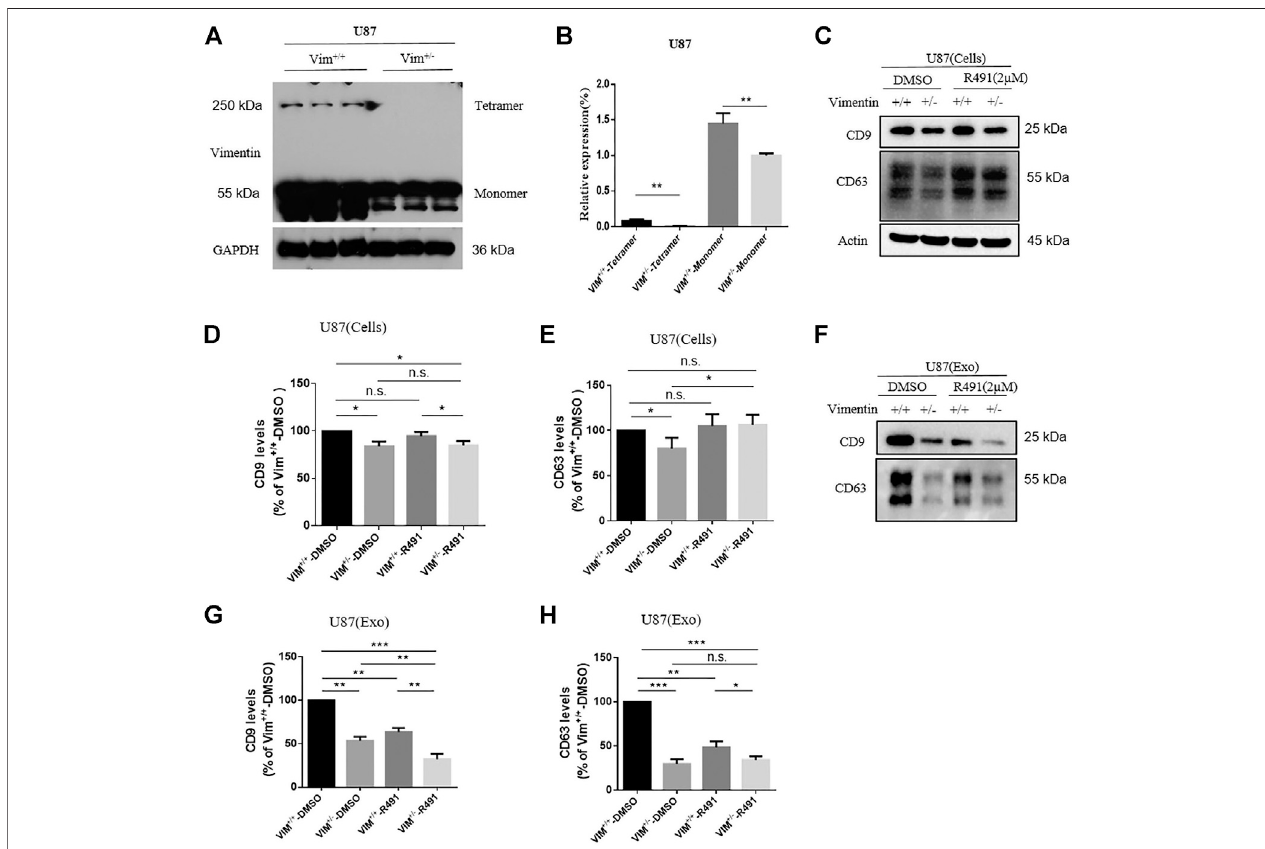
FIGURE 5 | Vimentin regulates exosome formation and release while the vimentin-binding compound R491 inhibits exosome release only. (A) A representative western blot analysis of vimentin tetramer and vimentin monomer from cell lysates of U87 Vim +/+ and U87 Vim +/- cells. (B) Quanti fi cation of the protein levels of vimentin from (A) in three independent experiments. (C) A representative western blot analysis of cell lysates from equal numbers of U87 Vim +/+ and U87 Vim +/- cells after being treatedwithDMSOorwith2 µMofR491for72 h.Celllysates(Cells)wereblottedfortheexosomalmarkersCD9andCD63,and β -actinasaloadingcontrol. (D – E) Quanti fi cation of the protein levels of exosomal markers CD9 and CD63 from (C) in three independent experiments. (F) A representative western blot analysis of the lysates of extracellular vesicles puri fi ed from the cultures with equal numbers of U87 Vim +/+ and U87 Vim +/- cells after being treated with DMSO or with 2 µM of R491 for 72 h. Extracellular vesicles (Exo) were extracted and blotted for the exosomal markers CD9 and CD63. (G – H) Quanti fi cation of exosomal markers CD9 and CD63 from (F) inthreeindependentexperiments.Thedataareexpressedasmean ± SEM(n (cid:2) 3).* p < 0.05,** p < 0.01and*** p < 0.001asdeterminedbytwo-tailedStudent ’ st-test.